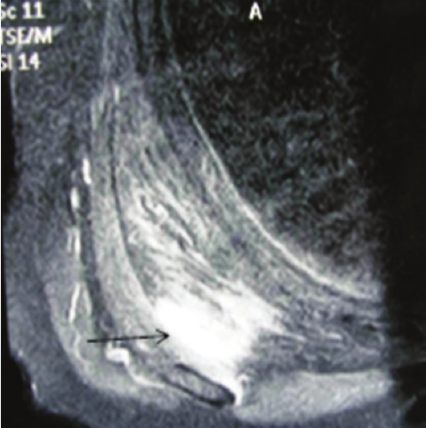
F 2: Fat suppression image aer gadolinium demonstrating rather homogenous enhancement of the mass.